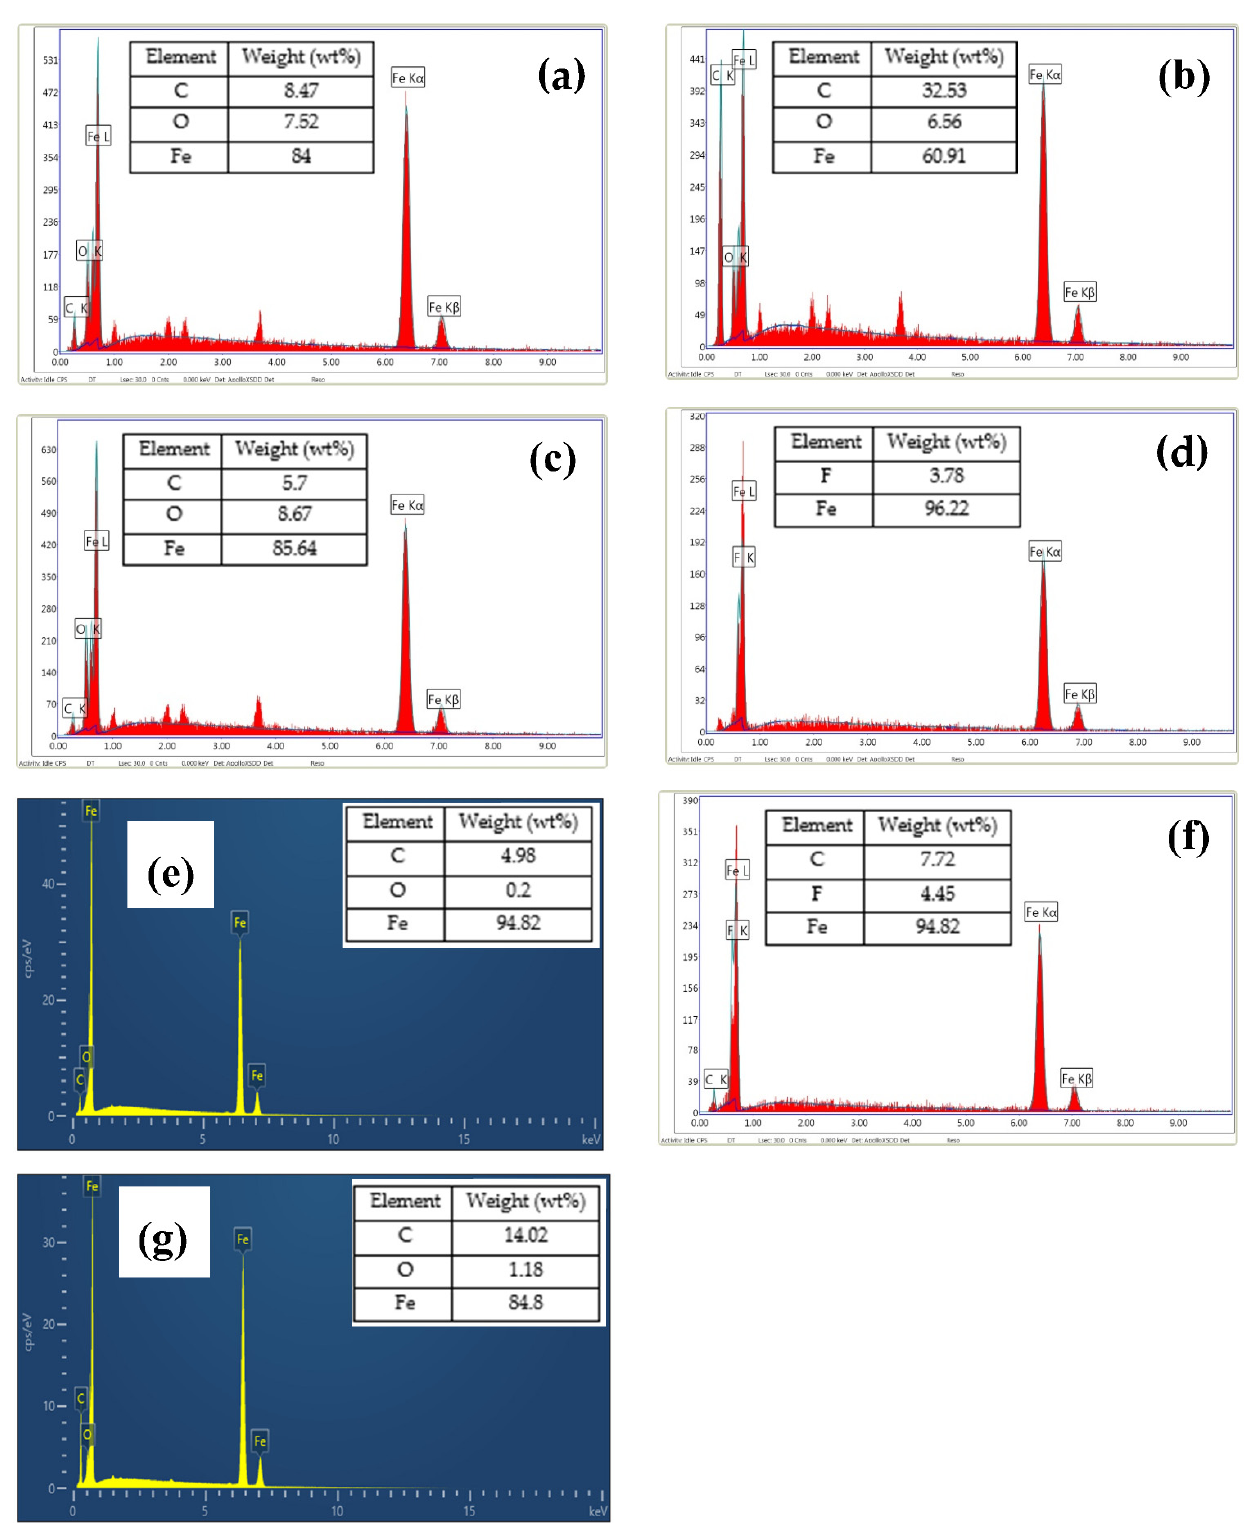
Figure 7. EDS analysis of worn surface on tested balls: ( a ) MO, ( b ) MO + 0.05, ( c ) MO + 0.2, ( d ) PO, ( e ) PO + 0.01, ( f ) PO + 0.05, and ( g ) PO + 0.2.